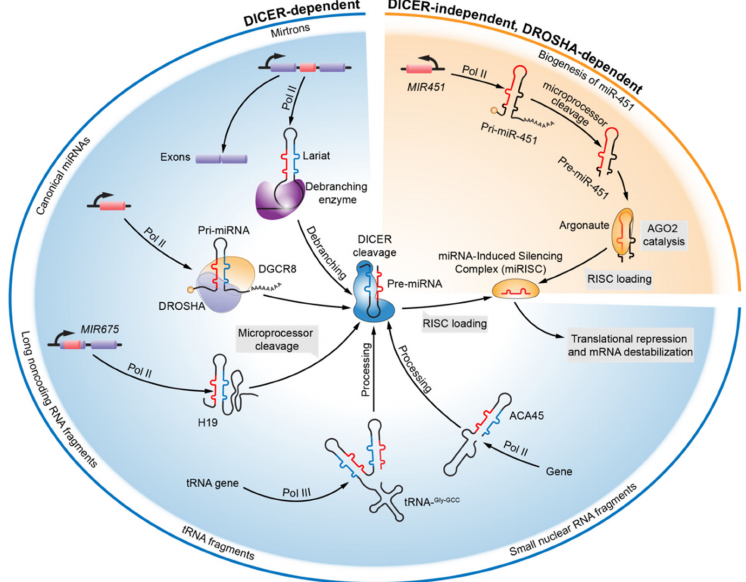
Figure 1. An overview of canonical and noncanonical miRNA biogenesis pathways. MiRNA genes are transcribed as primary transcripts (pri-miRNAs) by RNA polymerase II (Pol II) from intergenic or intronic